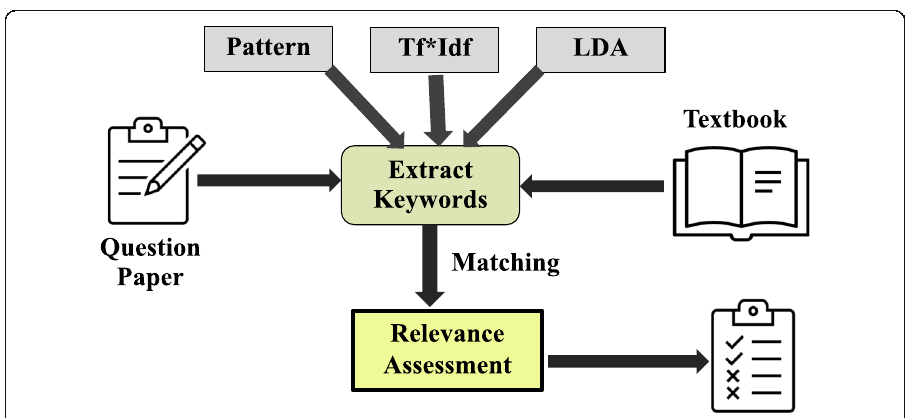
Fig. 2 A high-level workflow of Relevance